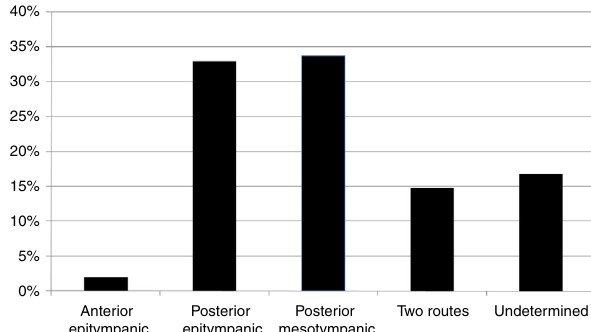
Prevalence of cholesteatomas according to their growth